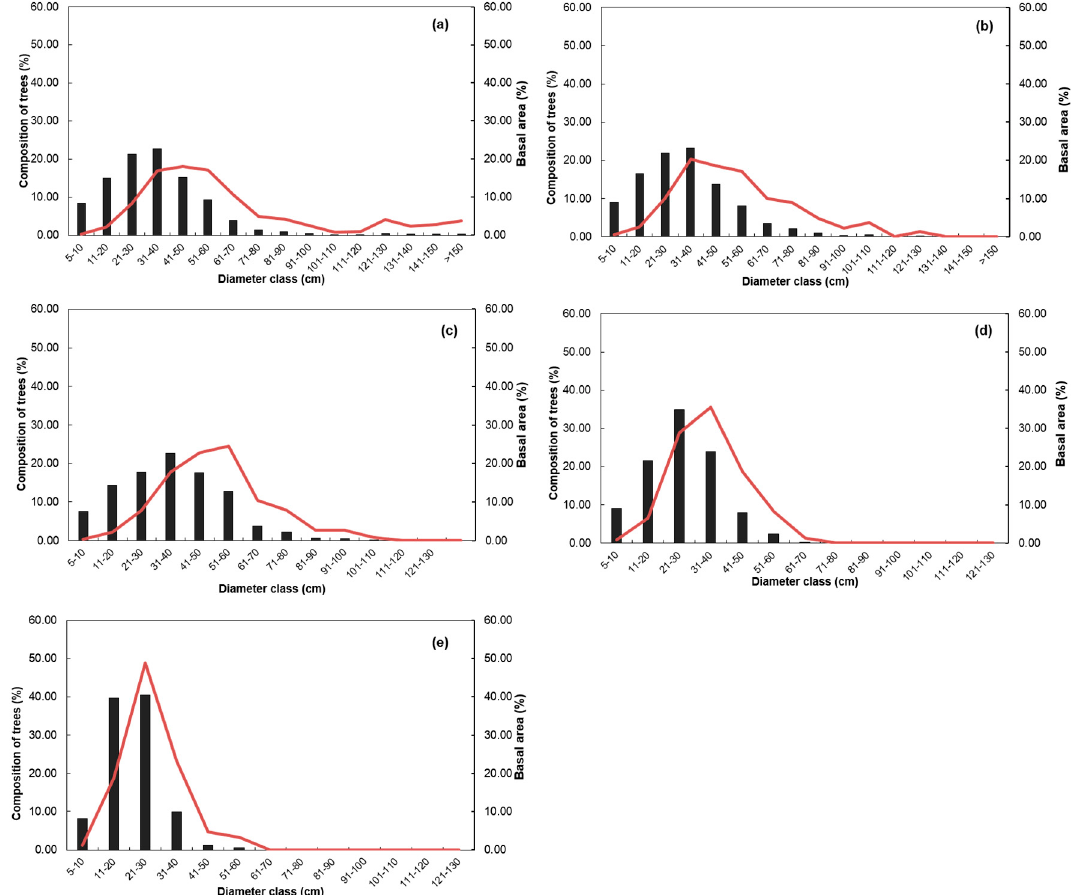
Figure 4. Diameter distribution of forests in ( a ) site 1; ( b ) site 2; ( c ) site 3; ( d ) site 4; and ( e ) site 5.